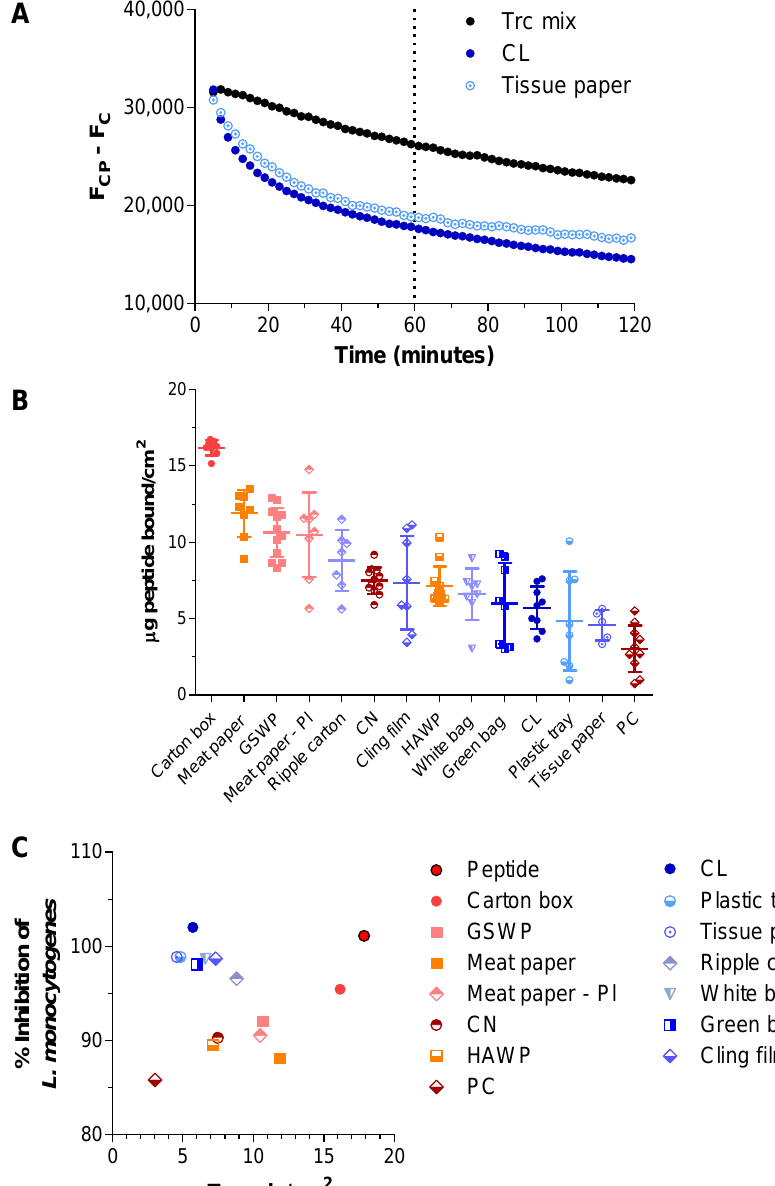
Figure 3. ( A ) Fluorescence decrease over time (background subtracted) as observed for Trc mix (50 µ g/mL), with cellulose and tissue paper as examples. Time point show at 60 min as ‘end point’ based on fluorescence decrease. ( B ) Amount of peptide bound ( µ g/cm 2 ) to each of the materials as calculated after 60 min of association. Each data set represents the mean of at least 6 technical repeats. The error bar represents the SD of the data cluster. Refer to Supplementary Materials for detail on concentration determination. ( C ) Relationship between peptide bound ( µ g/cm 2 ) and activity (percentage inhibition of L. monocytogenes ).